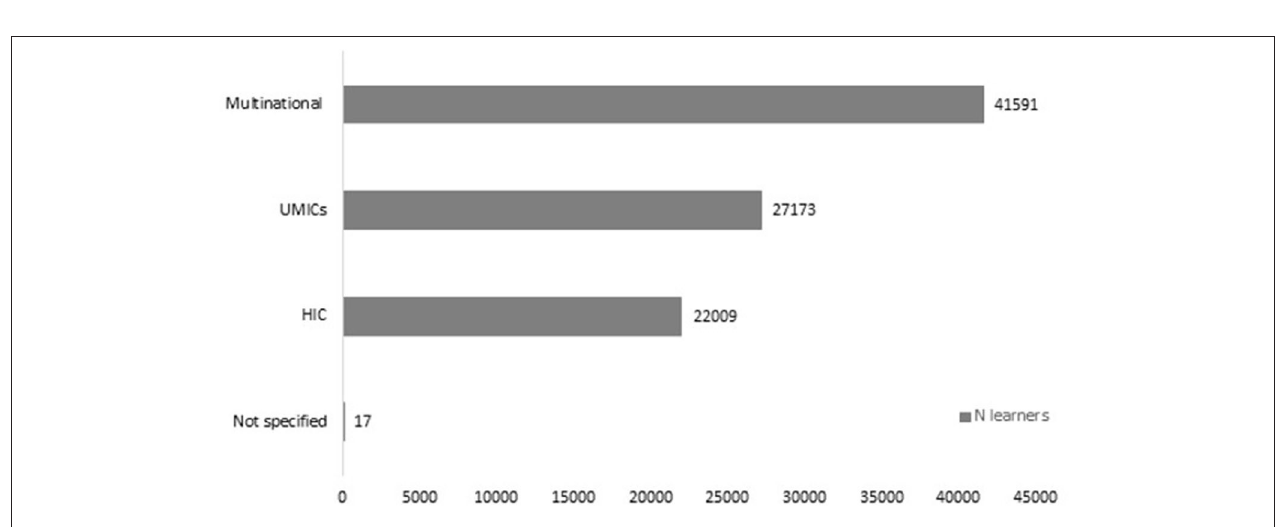
FIGURE 2 | Map of LMICs Learners’ location. Includes data from 28 included articles.